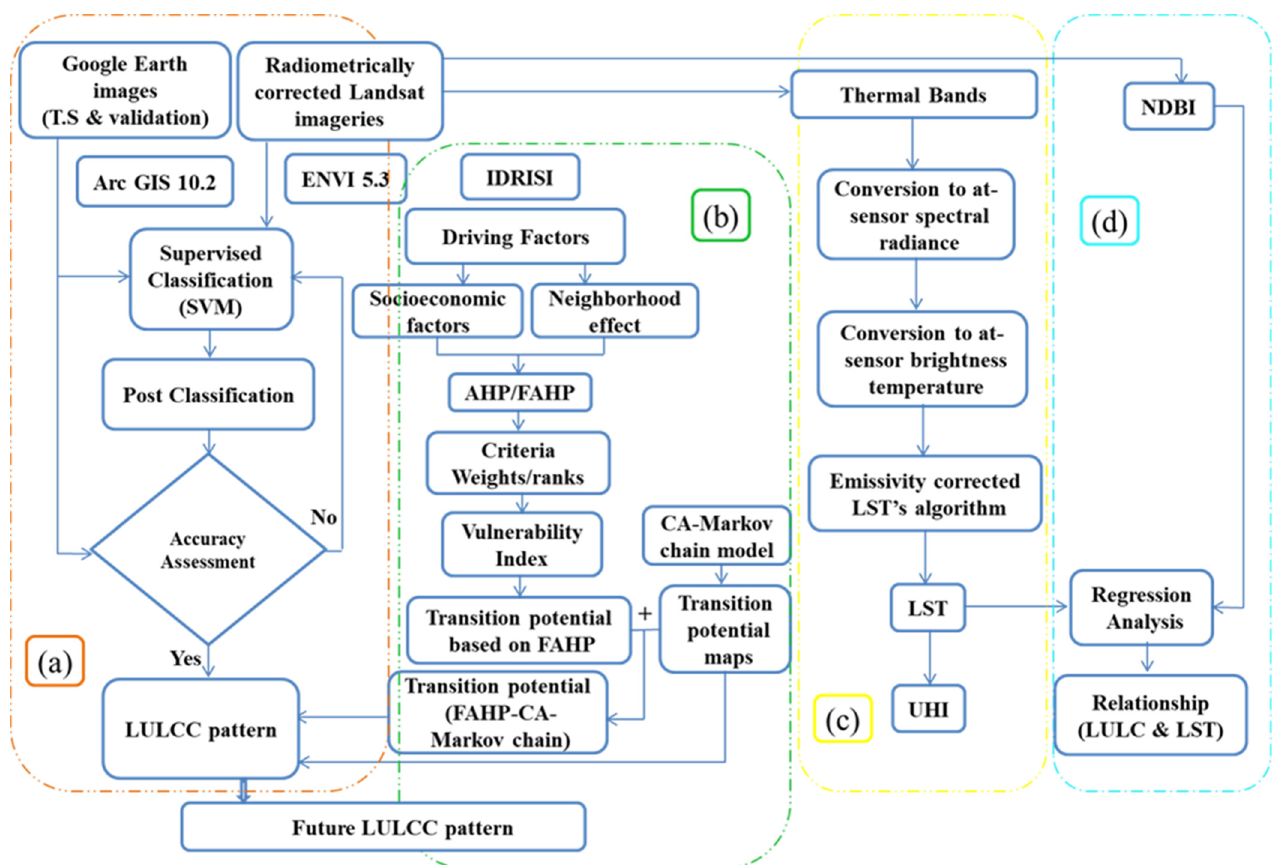
Figure 2. The conceptual flowchart of the adopted methodology. ( a ) Supervised classification of the processed images for obtaining LULC maps; ( b ) simulating the LULCC using CA-Markov chain model and the integrated model of CA-Markov chain with FAHP; and ( c ) estimation of LST and investigating the impact of LULCC on LST based on regression analysis; and ( d ) conducting regression analysis to obtain the relationship between LULC and the corresponding LST.